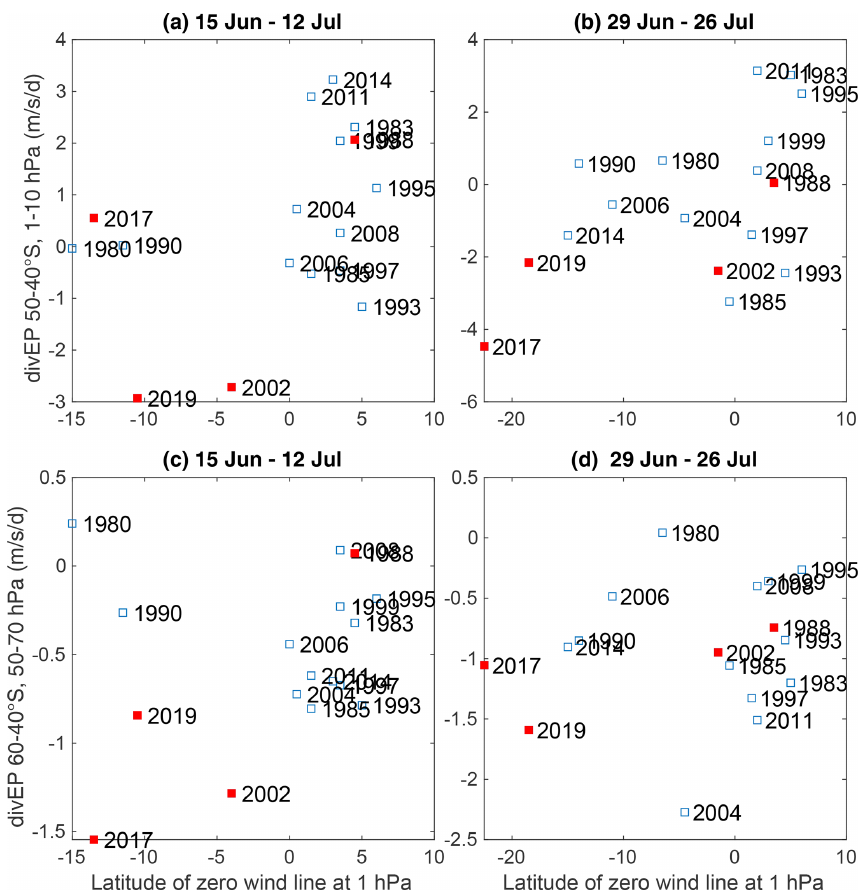
Figure 7. Latitude of the zero-wind line ( x axis) at 1hPa level vs. EP flux divergence (divEP, ms − 1 d − 1 , y axis). The left panels (a, c) show the means for 15 June–12 July, while the right panels (b, d) show the means for 29 June–26 July. In panels (a, b) the mean EP flux divergence is presented for 50–40 ◦ S and between 1 and 10hPa, while in panels (c, d) the mean EP flux divergence is for 60–40 ◦ S and between 50 and